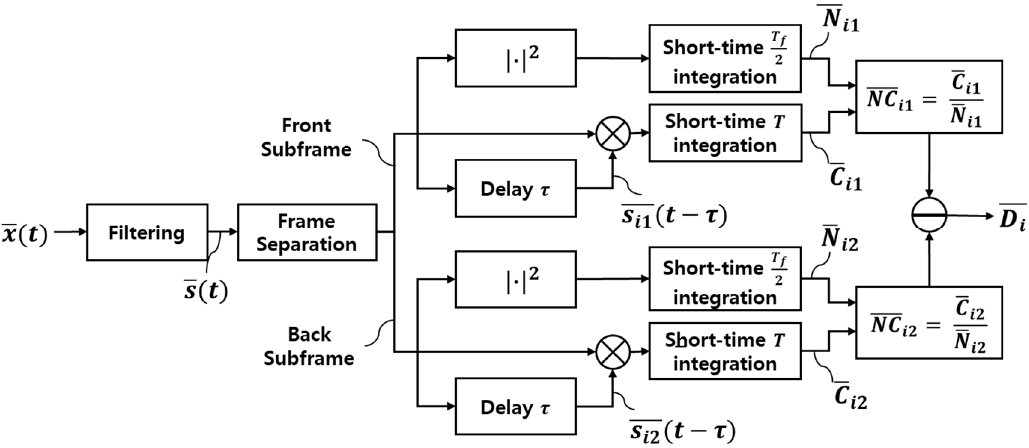
Figure 6. Watermark extraction procedure.